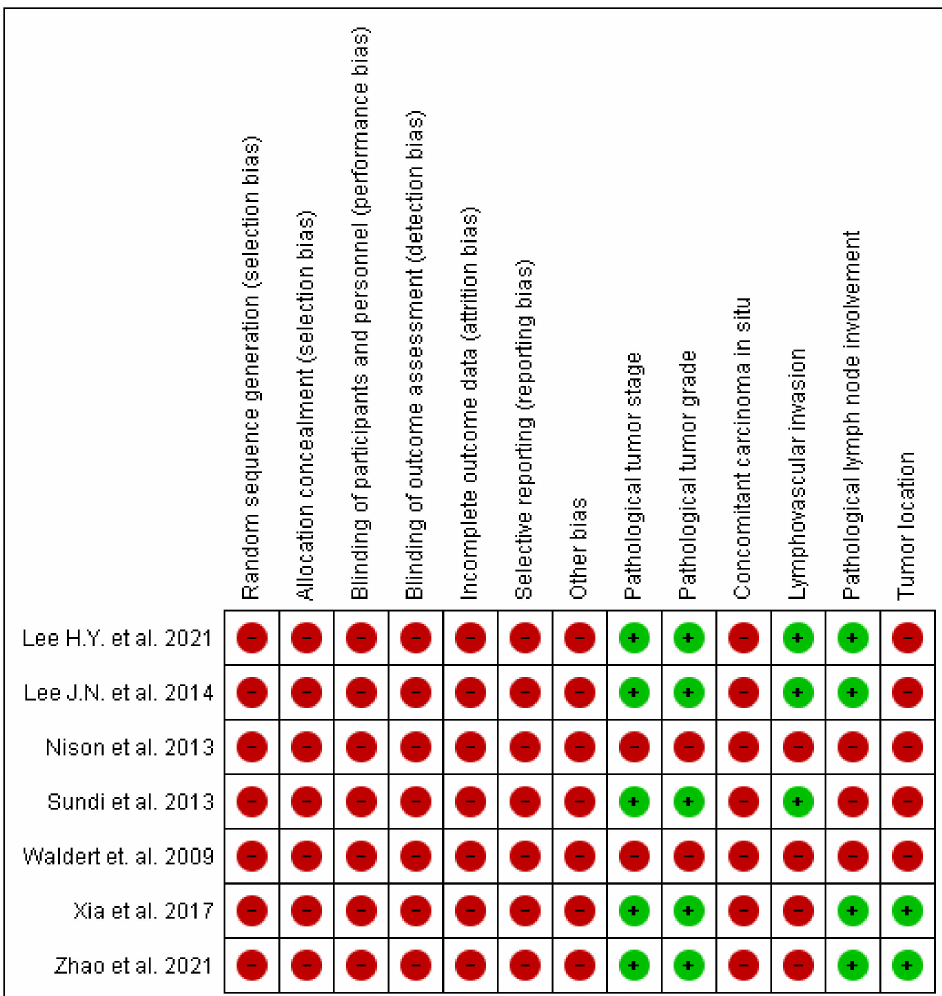
Figure 2. The risk of bias and confounding assessment for included studies